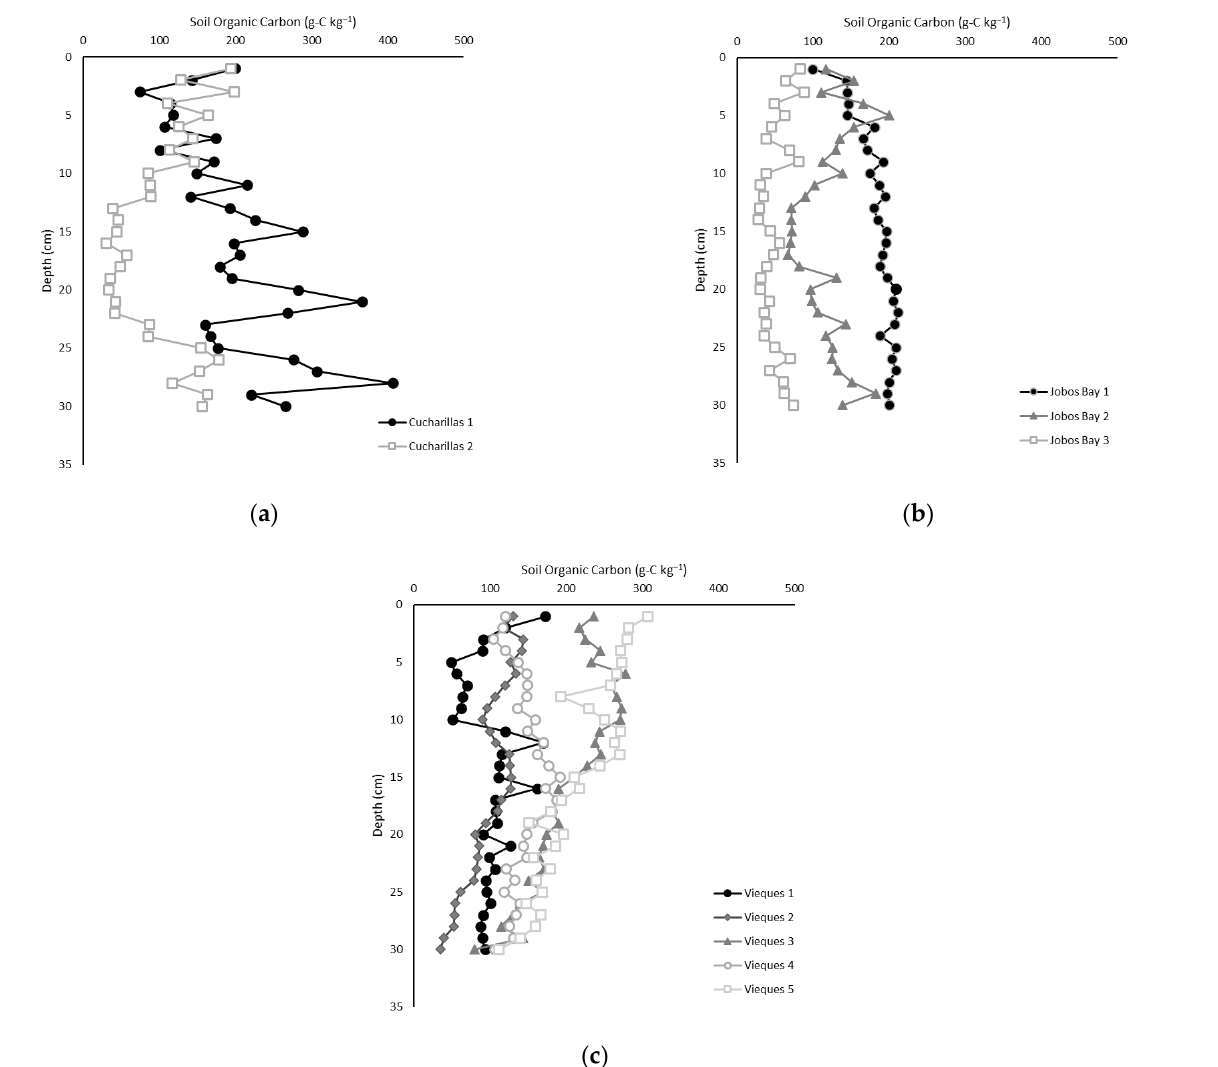
Figure 2. Soil organic carbon concentration at each 1 cm soil depth at each site in ( a ) Cucharillas, ( b ) Jobos Bay, and ( c ) Vieques.